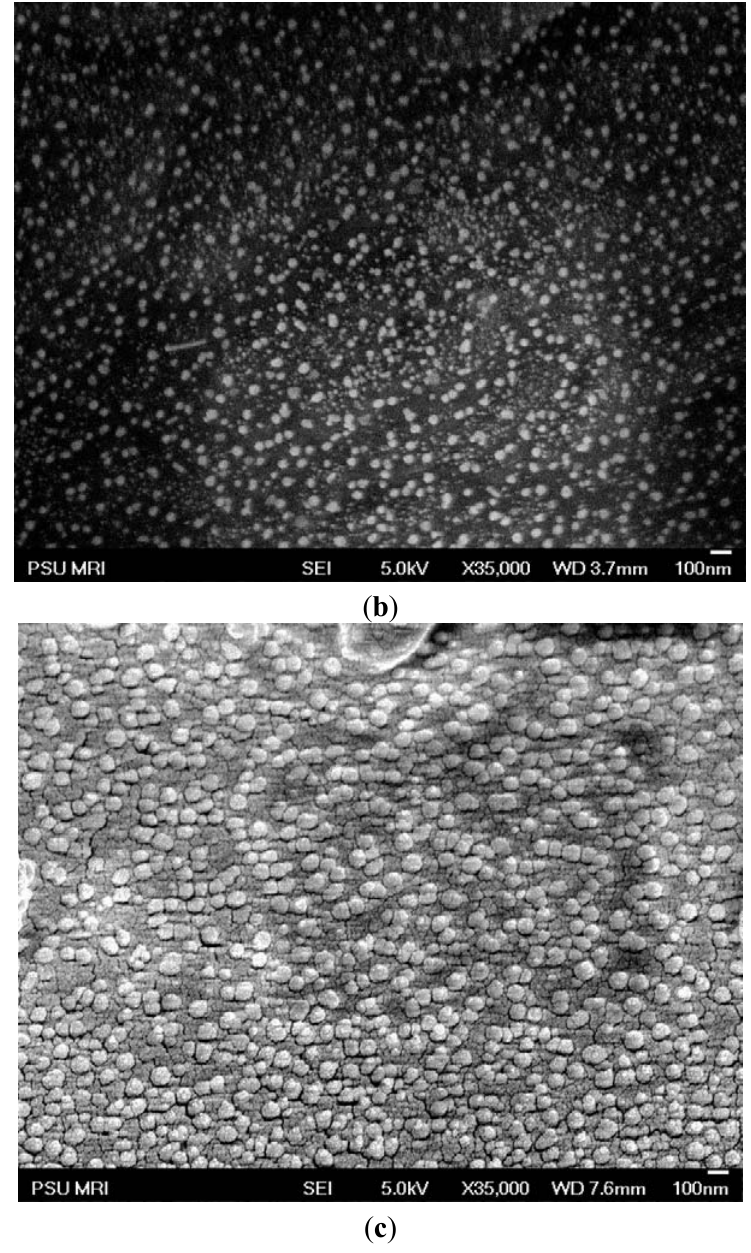
Figure 1. SEM micrographs of two PE-g-s-PAES membranes including ( a ) surface and ( b ) bulk of Sample A-2, and ( c ) the bulk of Sample A-4 in Table